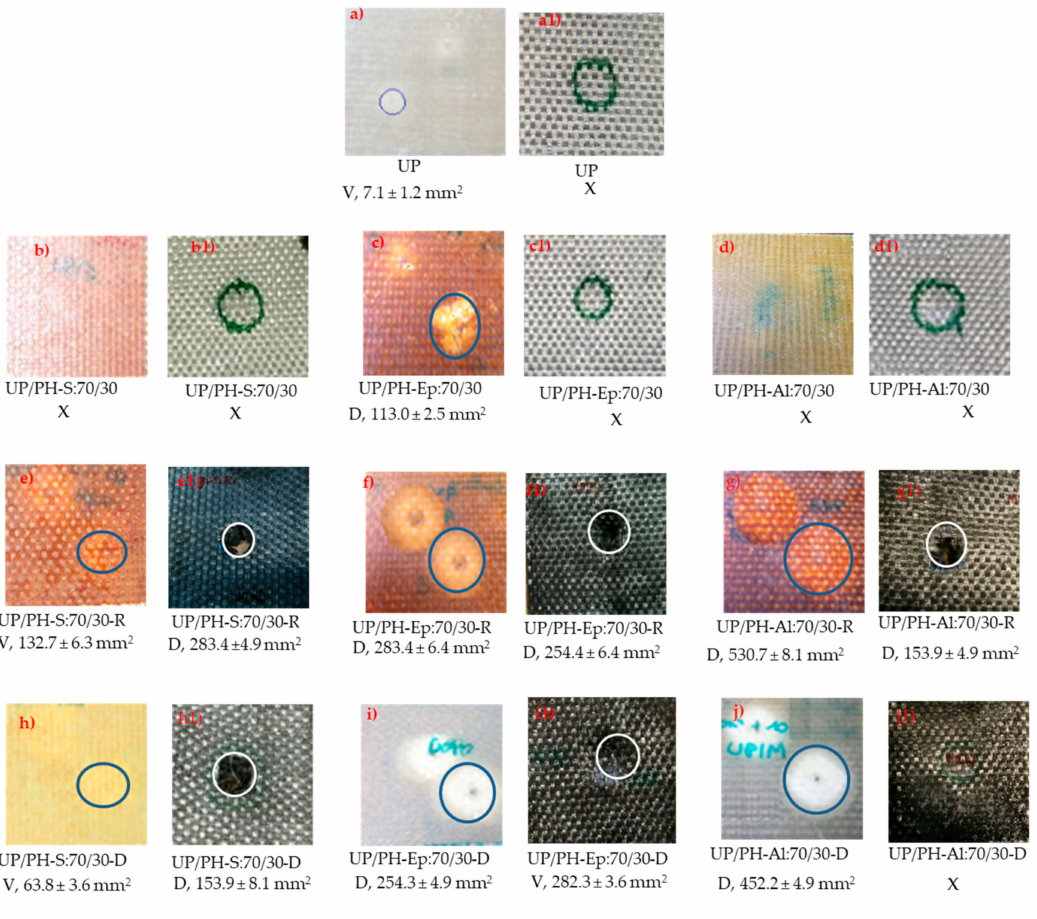
Figure 8. Digital images of impact damage and damage observations on the front (impacted) of all GFRC samples after